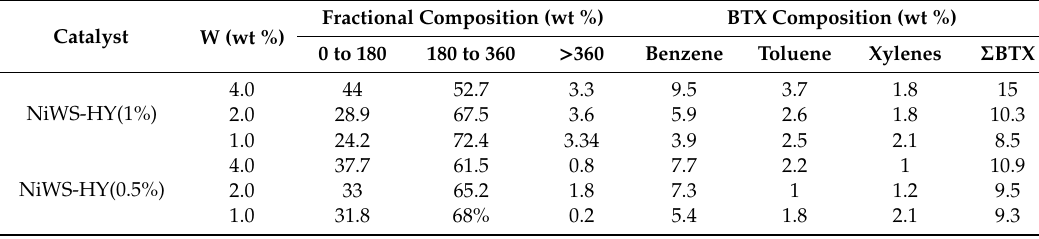
Table 3. Fractional composition of reaction products versus catalyst / feedstock ratio and zeolite content at 380 ◦ C with NiWS-HY(0.5%), NiWS-HY(1%) catalysts at standard conditions P = 5 MPa, t = 5 h,